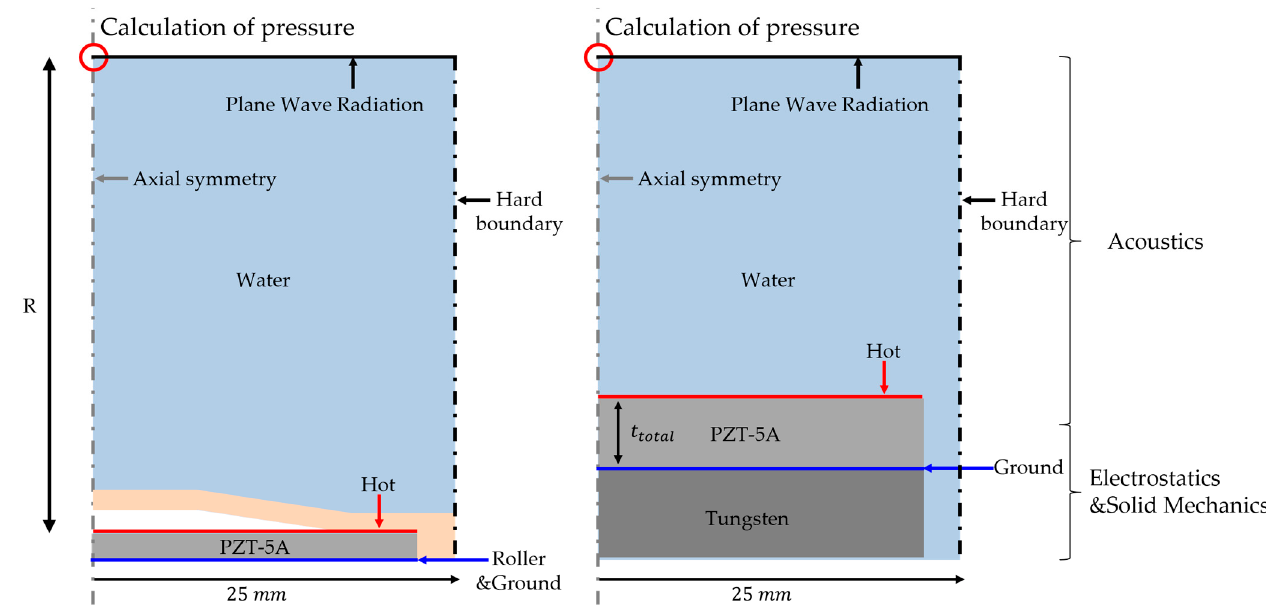
Figure 4. Finite element method (FEM) model of cymbal transducer and stacked PZT transducer.